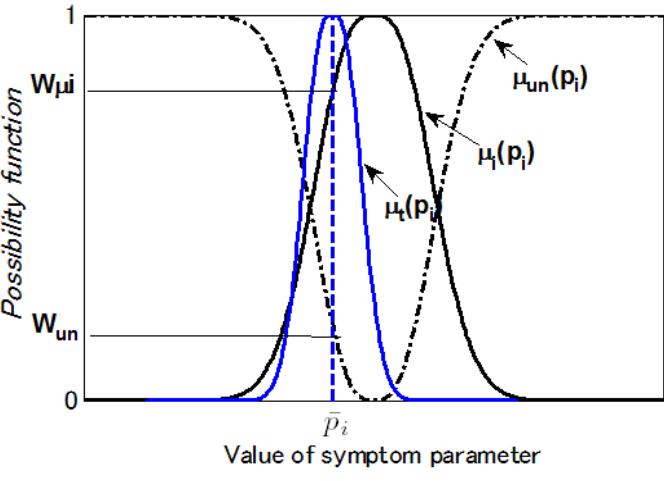
Figure 6. Matching examples of the possibility